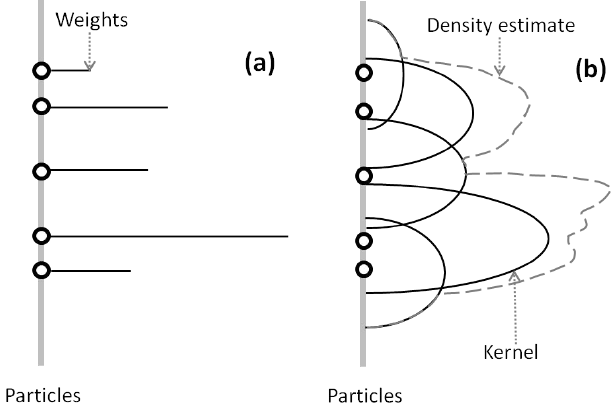
Fig. 1. The concept of discrete and continuous approximation of particle density: (a) weighted empirical measure, and (b) regular- ized measure by kernel. Adapted from Musso et al.